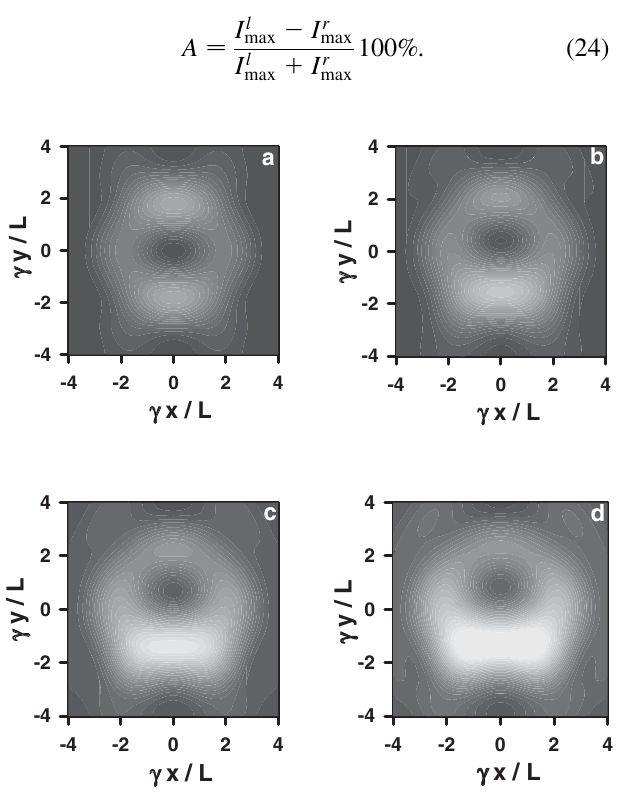
FIG. 6. DR 3D spatial distribution in the PWZ calculated for different offsets of the particle trajectory with respect to the slit (cid:5) 0 , (b) a (cid:5) 45 (cid:8) m , (c) a (cid:5) 75 (cid:8) m , center: (a) a s s s (cid:5) 90 (cid:8) m . Calculation parameters: (cid:1) (cid:5) 2500 , (cid:2) (cid:5) (d) a s (cid:5) 9 mm , a (cid:5) 0 : 185 mm , b (cid:5) 7 mm , b (cid:5) 500 nm , a out in out in (cid:5) 0 , (cid:6) (cid:5) 45 (cid:14) , j R j 2 (cid:5) 0 : 61 , and j R j 2 (cid:5) 0 : 37 . 5 mm , b s x y 0